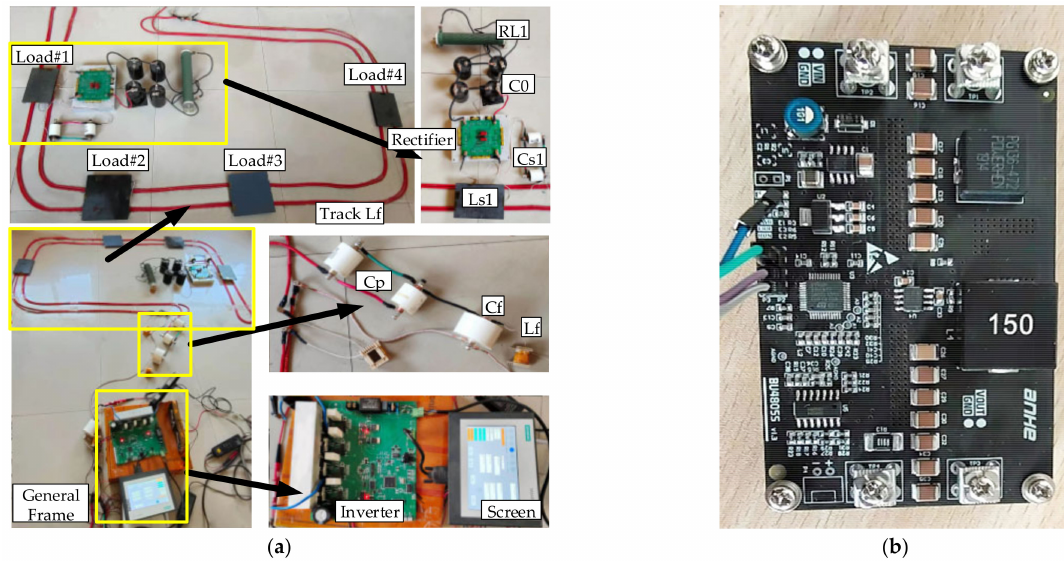
Figure 16. ( a ) Experimental setup. ( b ) DC–DC